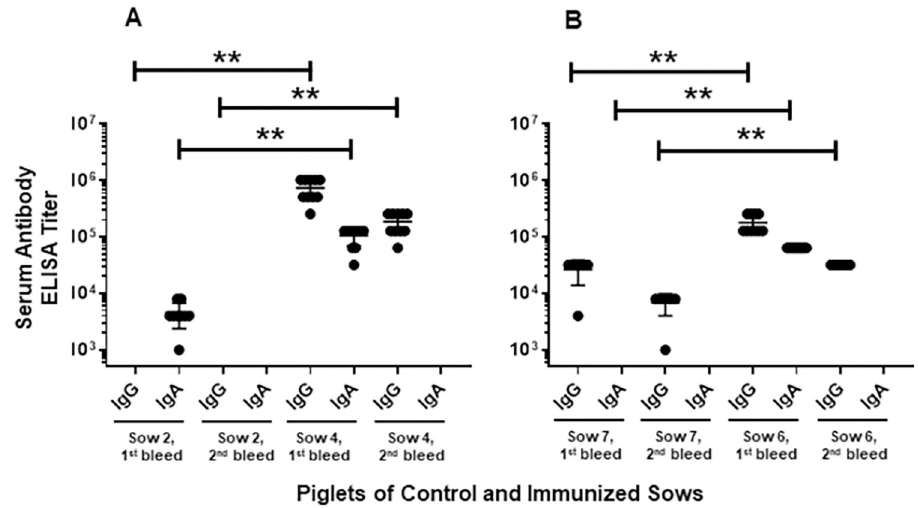
Fig 1. Serum IgG and IgA levels (reciprocal ELISA titers) of piglets before the parasite challenge (1 st bleed) and at the end of the experiment (2 nd bleed) against Cryptosporidium parvum . (A) Serum IgG and IgA levels of piglets of the control (sow 2) and immunized (sow 4) sows that were challenged with C . parvum . (B) Serum IgG and IgA levels of piglets of the control (sow 7) and immunized (sow 6) sows that were challenged with C . hominis . �� p <